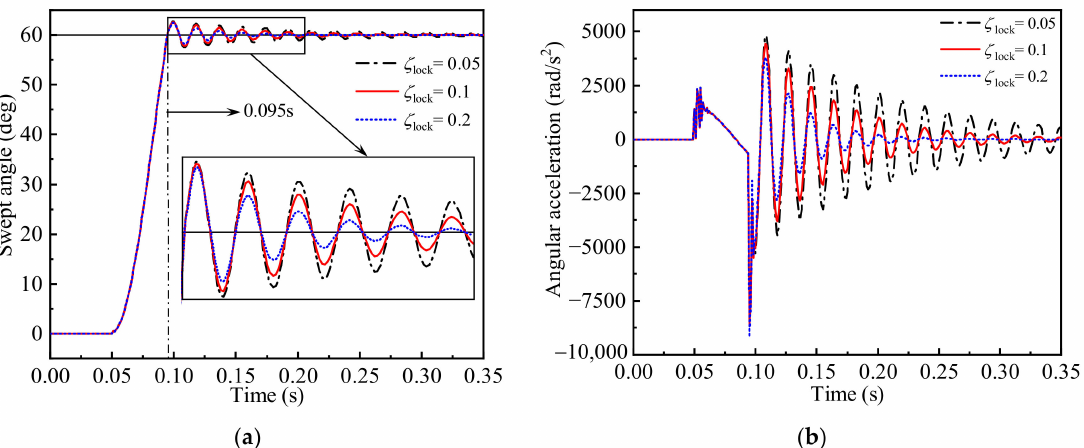
Figure 13. Time histories of the overall rotation motion of the wing. ( a ) Wing rotation angle vs. time. ( b ) Angular acceleration vs. time.